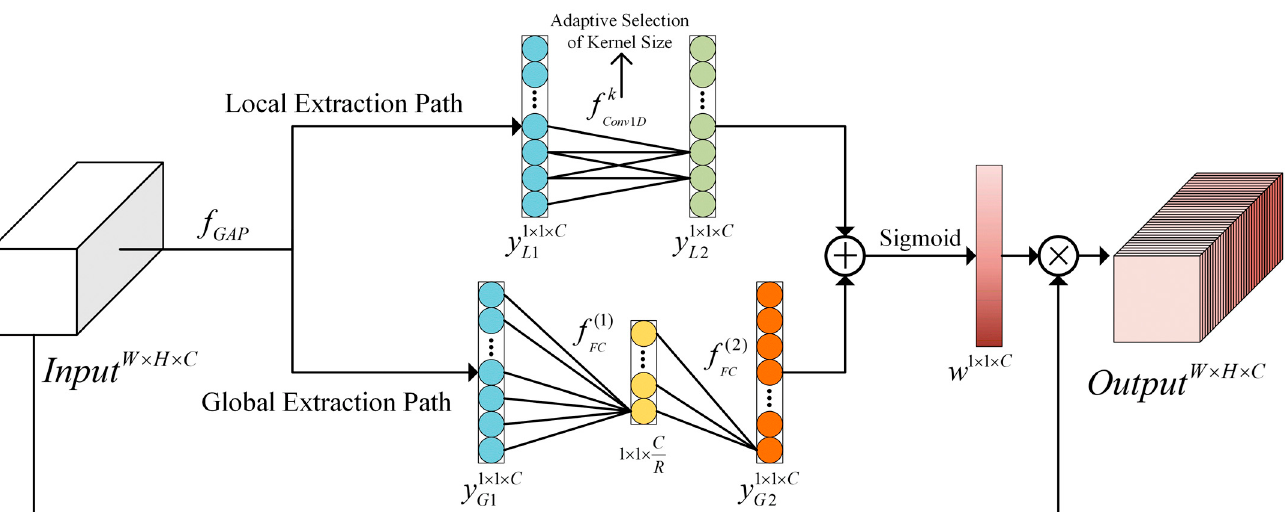
Figure 5. The structure comparison between CBL × 5 ( a ) and the proposed S-CBL × 5 ( b ). To highlight significant features related to the detection task, the DCA Block was proposed to optimize the weight distribution of each feature map in the channel dimension by combining the local and global relationship between channels with a slight increase in computations cost and inference time. The structure of the DCA Block is shown in Figure 6.